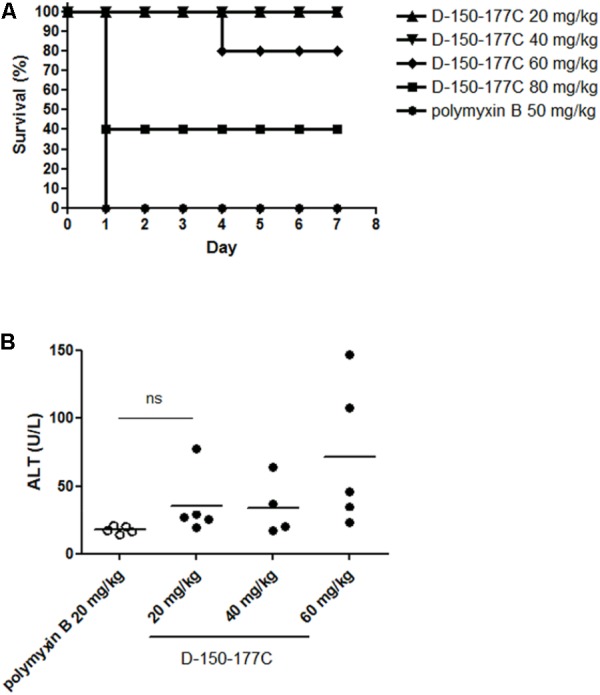
In vivo toxicity of D-150-177C peptide. At day 0, male ICR mice (5 mice/group) were i.p. injected with different doses of D-150-177C peptide (20–80 mg/kg) and polymyxin B (50 mg/kg), respectively. (A) The survival rates of all groups were monitored for 7 days. All mice treated with polymyxin B (50 mg/kg) died at day 1. In contrast, no acute toxicity was observed in mice treated with 20 and 40 mg/kg D-150-177C. When we increased the dose to 60 and 80 mg/kg, the survival rates of mice were decreased to 80 and 40%. (B) Alanine aminotransferase activity (ALT) was measured in serum samples of mice treated with D-150-177C or polymyxin B at day 1. The horizontal bars represent the means of ALT values of ICR mice in different experimental groups. Treatment with D-150-177C in the dose of 20 and 40 mg/kg showed a slight increase in the ALT level than treatment with polymyxin B at 20 mg/kg. The ALT level of mice treated with 60 mg/kg D-150-177C was significantly higher than that treated with polymyxin B at 20 mg/kg (P < 0.01).